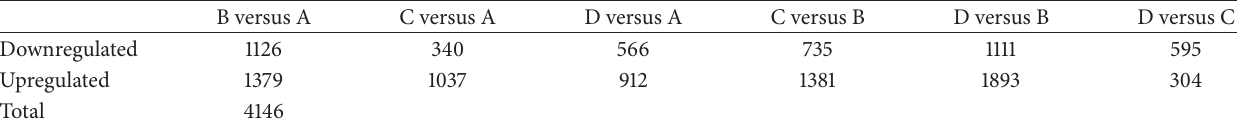
Table 2: Differentially expressed genes across all